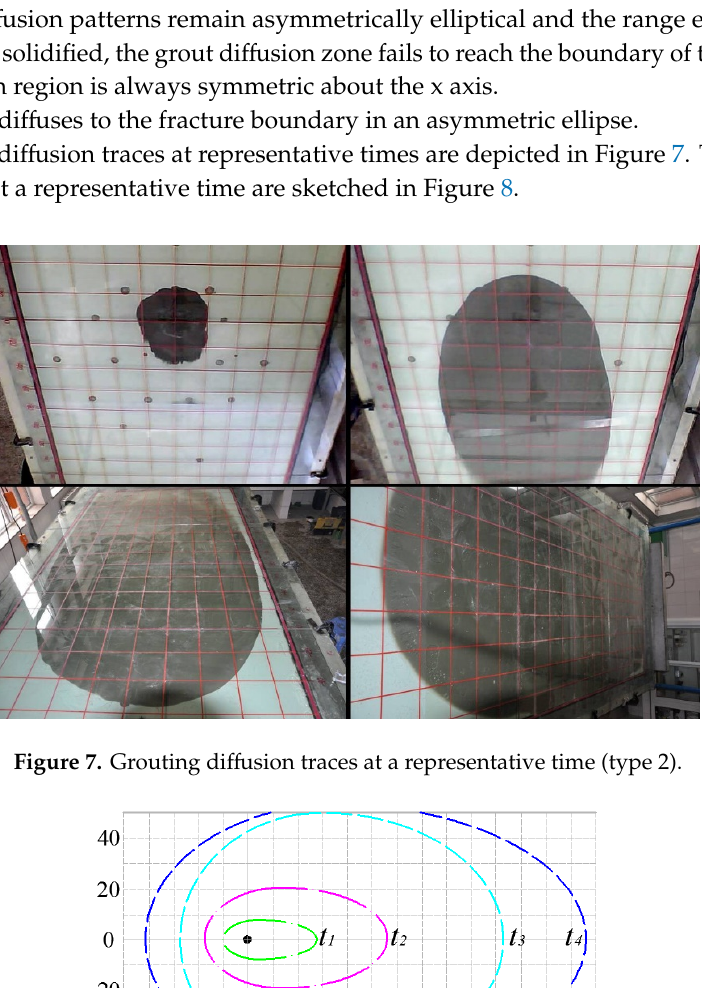
Figure 6. Grouting di ff usion sketch at a representative time (type 1).